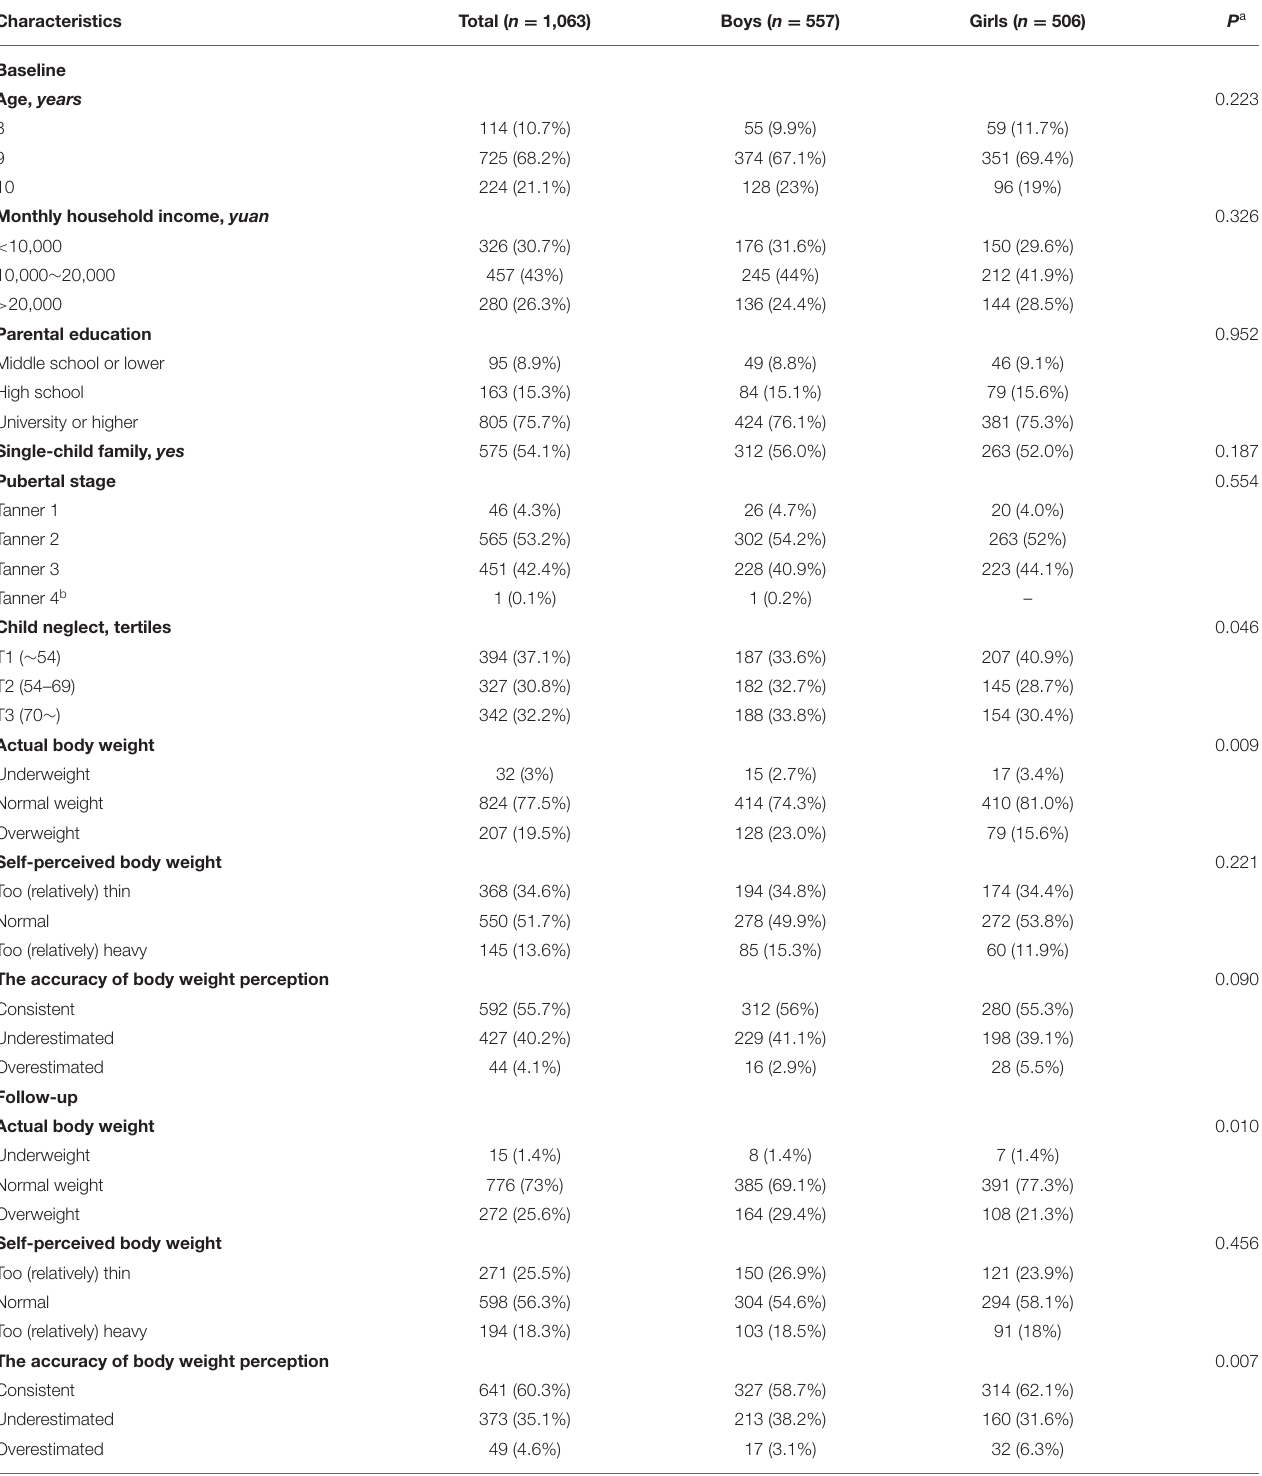
TABLE 1 | Descriptive characteristics in the sample of 1,063 primary